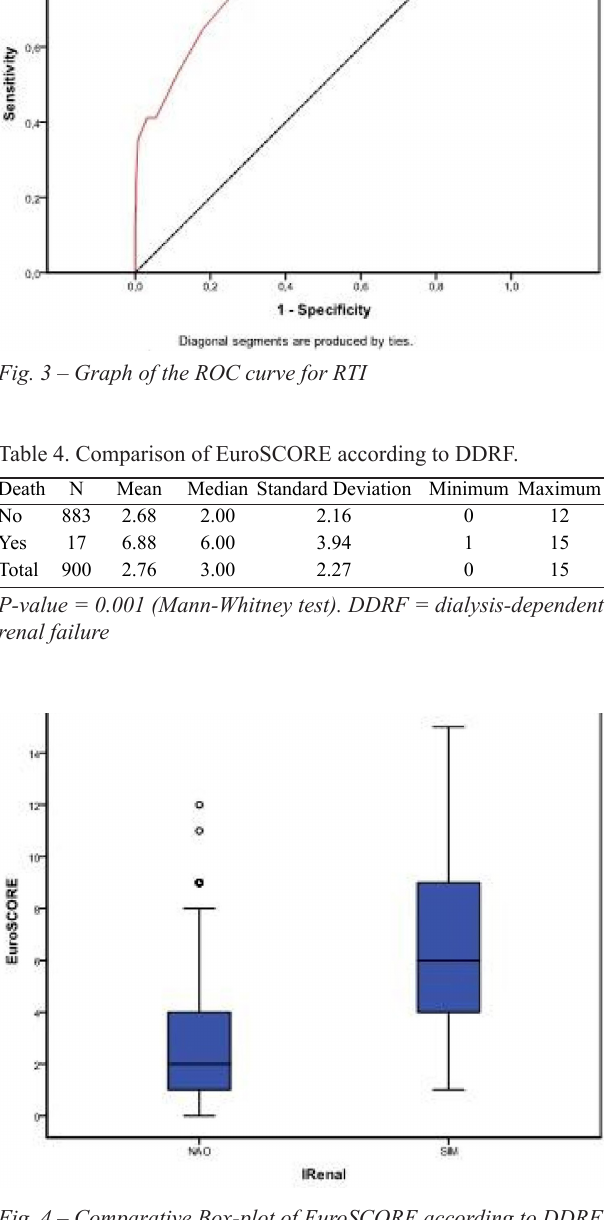
Fig. 4 – Comparative Box-plot of EuroSCORE according to